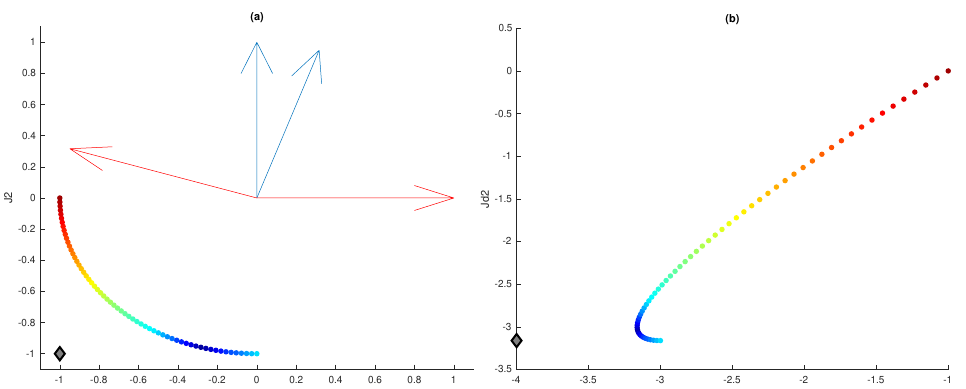
Figure 4. ( a ) Pareto front colored according to proximity to ideal point computed in the basis and plotted in canonical basis. Vectors of preference directions in blue and vectors of dominance directions in red. ( b ) Same points but plotted in the basis